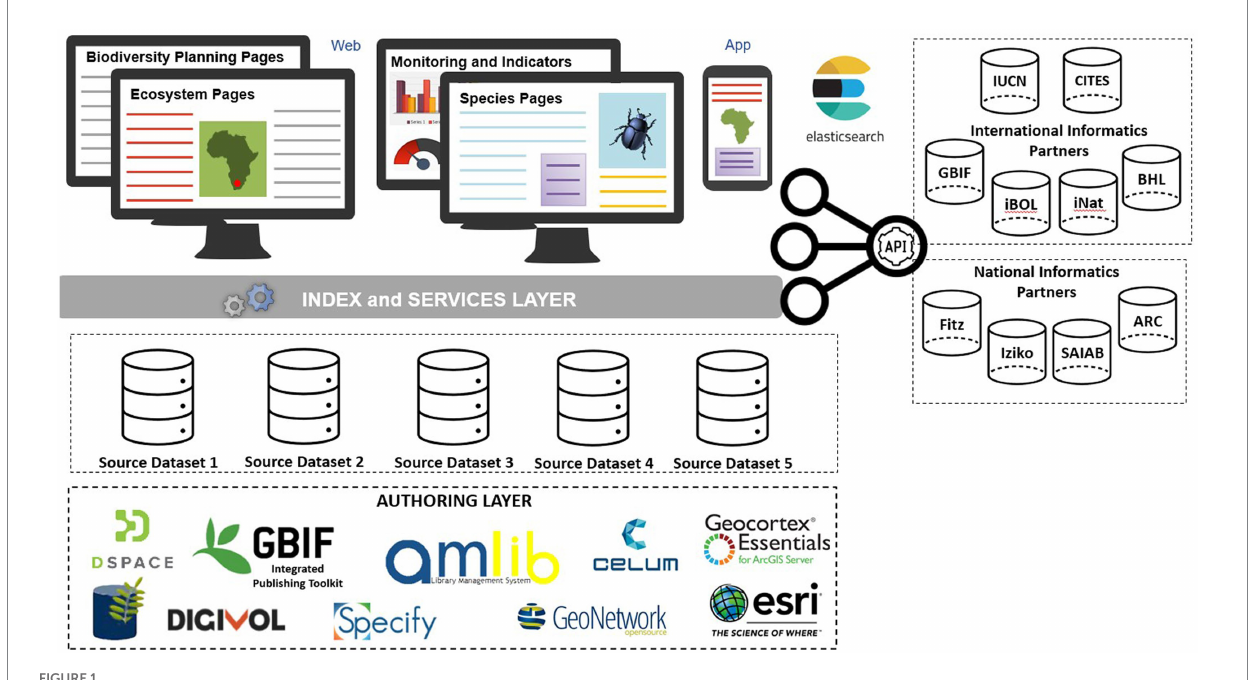
FIGURE 1 Service orientated architecture model for data